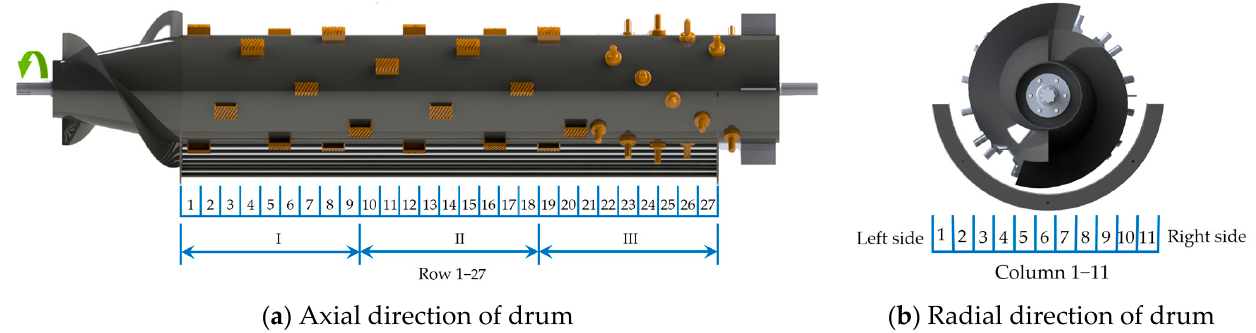
Figure 3. The arrangement of collection boxes.